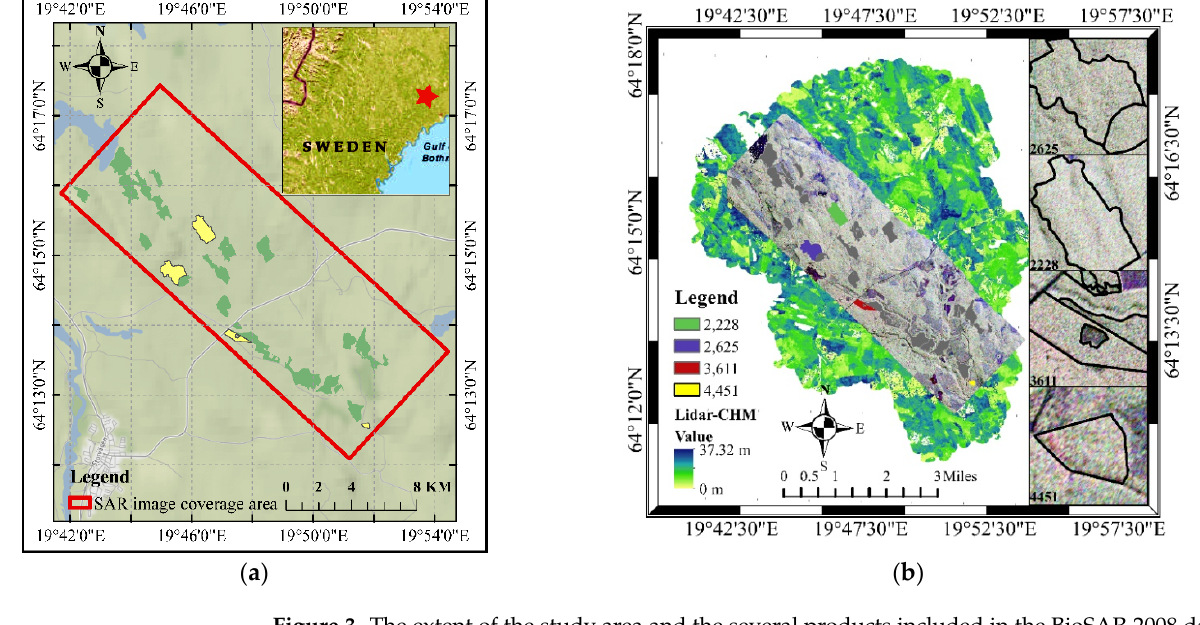
Figure 3. The extent of the study area and the several products included in the BioSAR 2008 dataset. ( a ) The red pentagram in the upper right corner of the thumbnail depicts the location of the study area in Sweden. The red rectangle region shows the SAR image. The green and yellow polygons represent the 31 forest stands in the red rectangle region; the four yellow polygons represent the forest stands employed in this study. ( b ) The green background image is a Lidar image with a grid size resampling of 1m*1m. Pauli ‐ basis image is the extent of SAR images. The Pauli ‐ basis image (on the left) shows the locations of the four forest stands. The shape of four forest stands on the Pauli ‐ basis image is shown on the right. All products on the map are geocoded to WGS84 UTM Zone 34N.